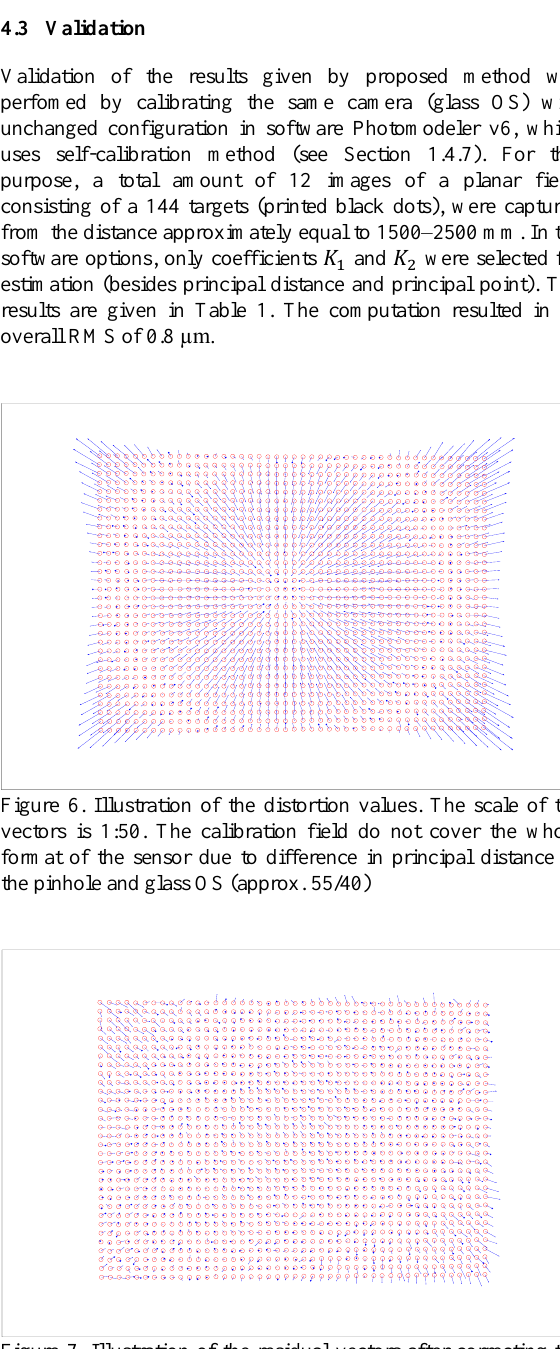
Figure 7. Illustration of the residual vectors after correcting the image coordinates from distortion by using radial distortion polynomial. The scale of the vectors is